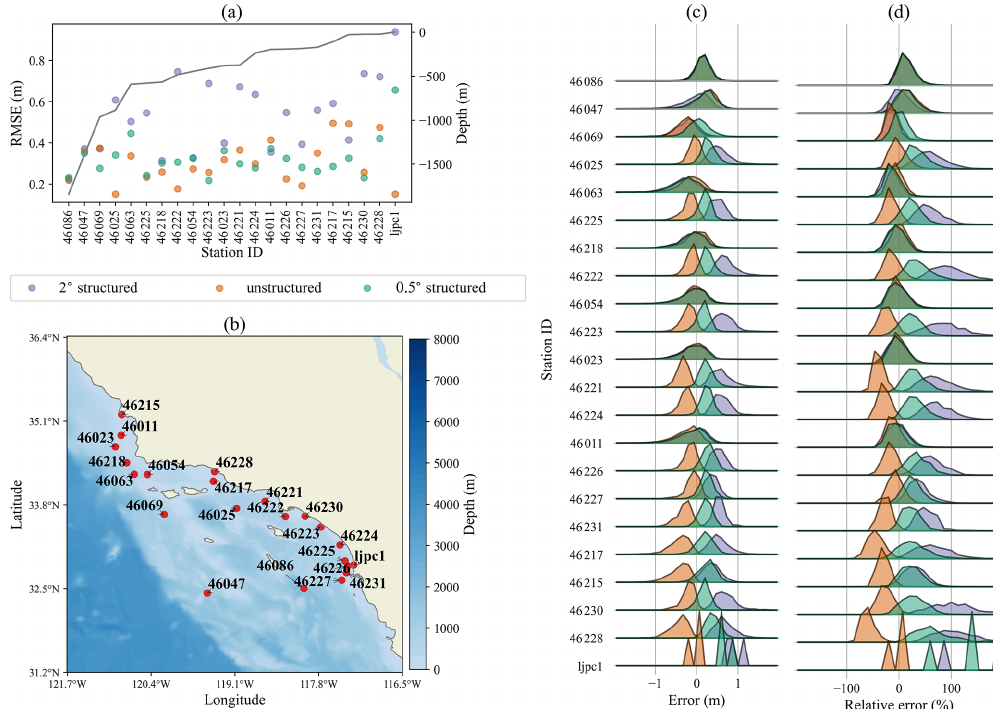
Figure 7. Same as Fig. 3 for stations along the Southern California coast.